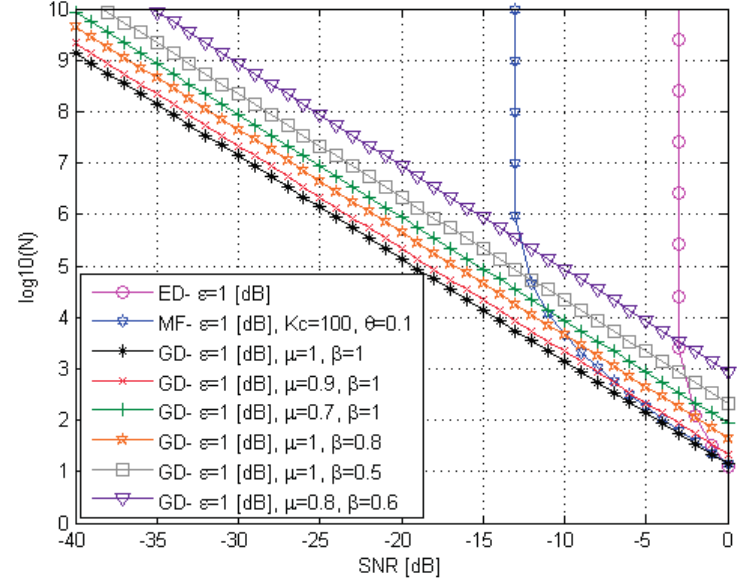
Figure 6. The GD sample complexity at the